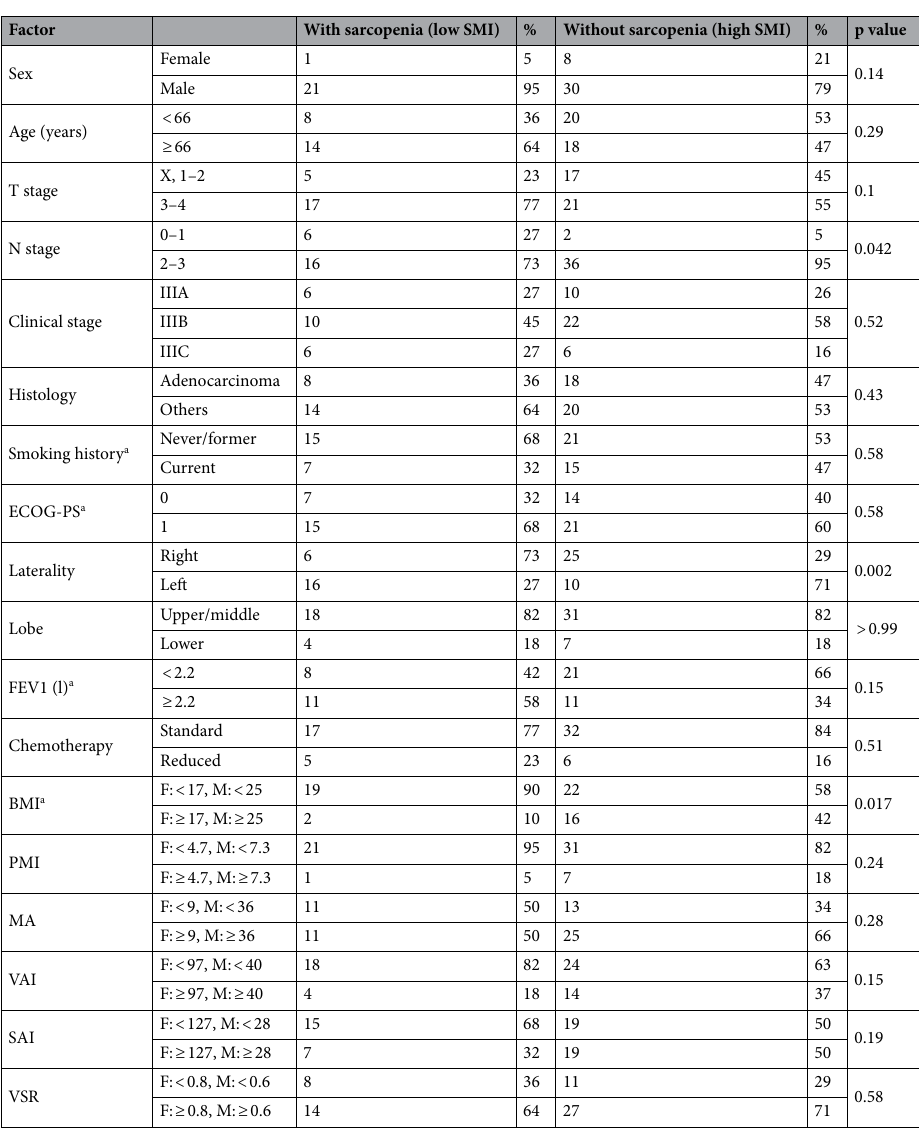
muscle attenuation, SMI skeletal mass muscle index, PMI psoas muscle index, VAI visceral adiposity index, SAI subcutaneous adiposity index, VSR visceral-to-subcutaneous fat ratio, CI confidence interval. a These variables have missing